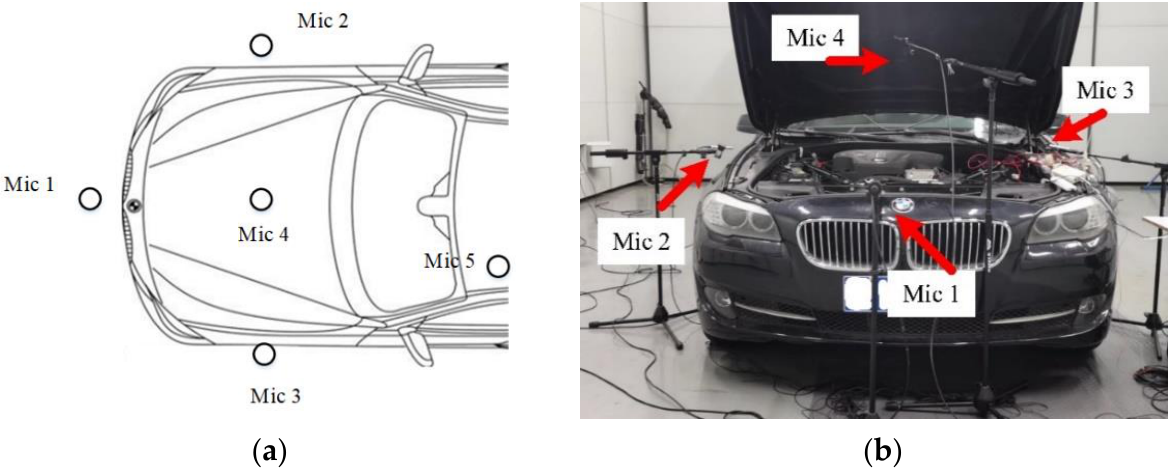
Figure 6. Experimental arrangement of vehicle engine noise measurement: ( a ) Microphone arrangement; ( b ) Experimental apparatus arrangement.